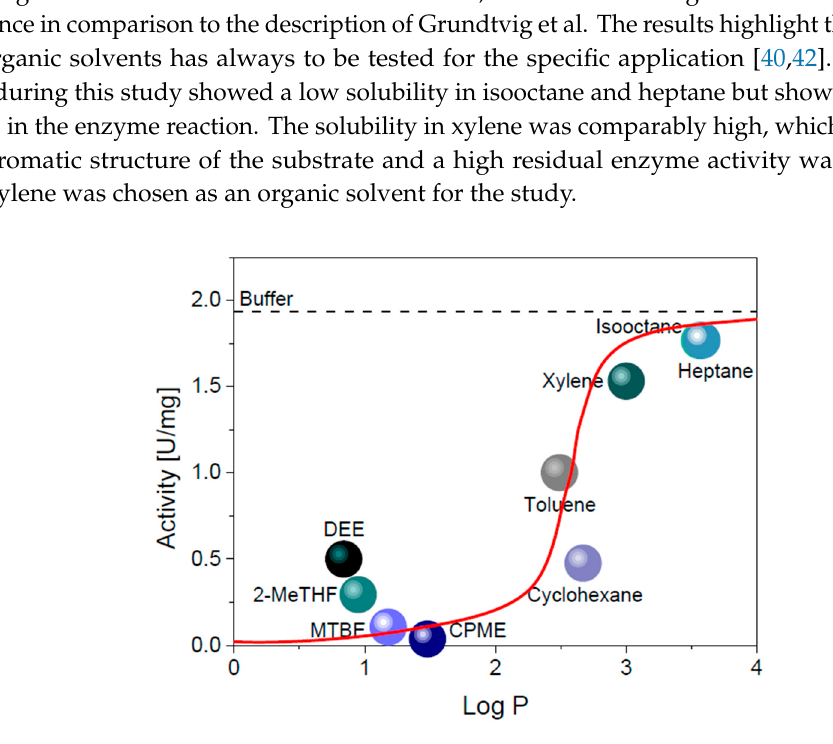
Figure 2. Solvent screening regarding residual enzyme activity. Solid line: in literature, described influence of LogP value on enzyme activity. [40] Dashed line: enzyme activity in buffer without organic solvent. Conditions: with organic solvent saturated Tris-HCl buffer (pH 7, 0.1 M, 2 mM MgCl 2 ), c cinnamyl aldehyde = 0.1–6 mM, m ADH = 0.1 mg, c NADH = 0.1 mM, λ = 360 nm, 30 °C.